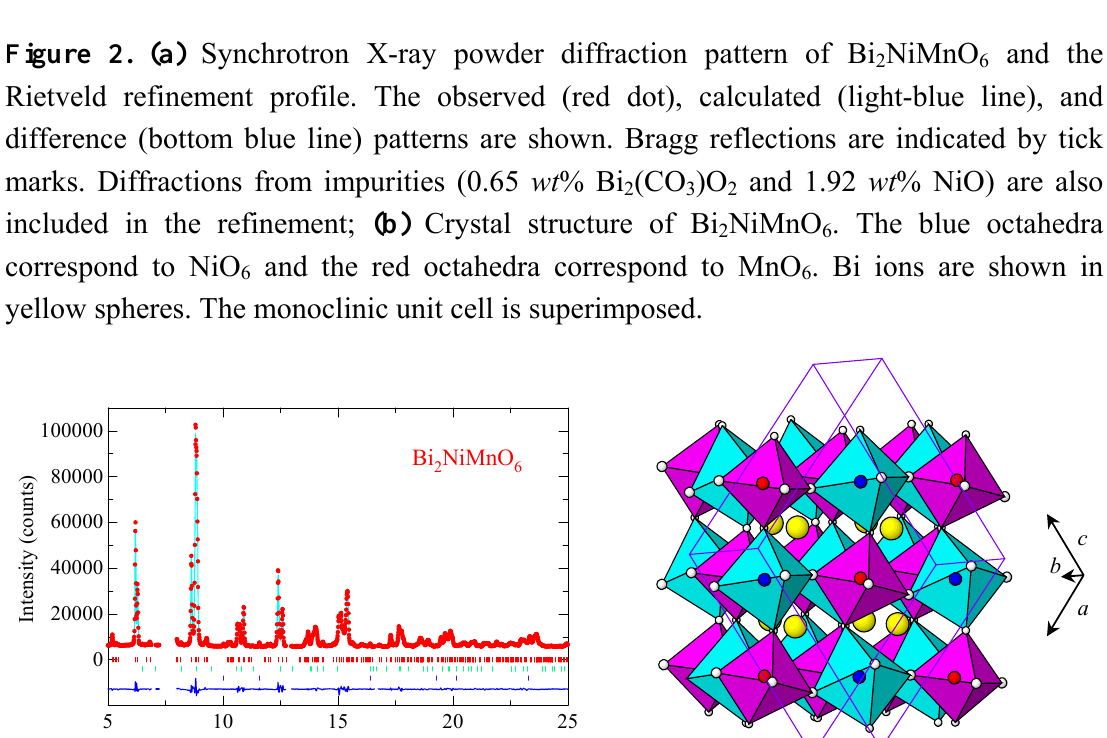
Table 1. Refined structure parameters of Bi